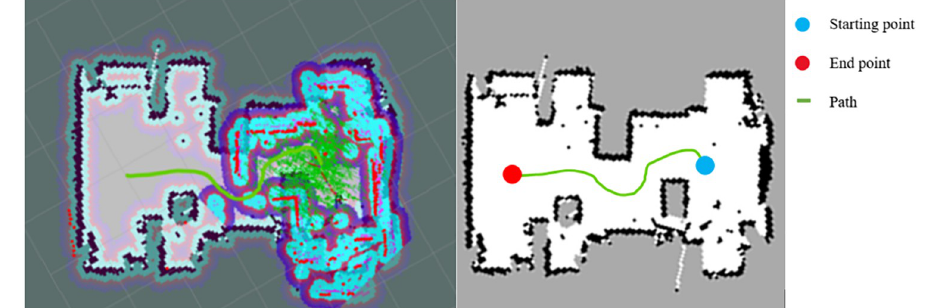
Fig 16. The rviz interface of path planning and extracted